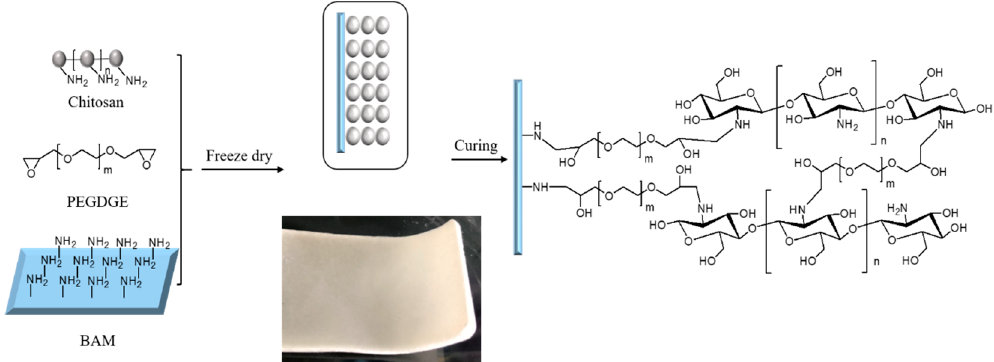
Figure 1. Schematic illustration of the preparation of double-layer membrane.